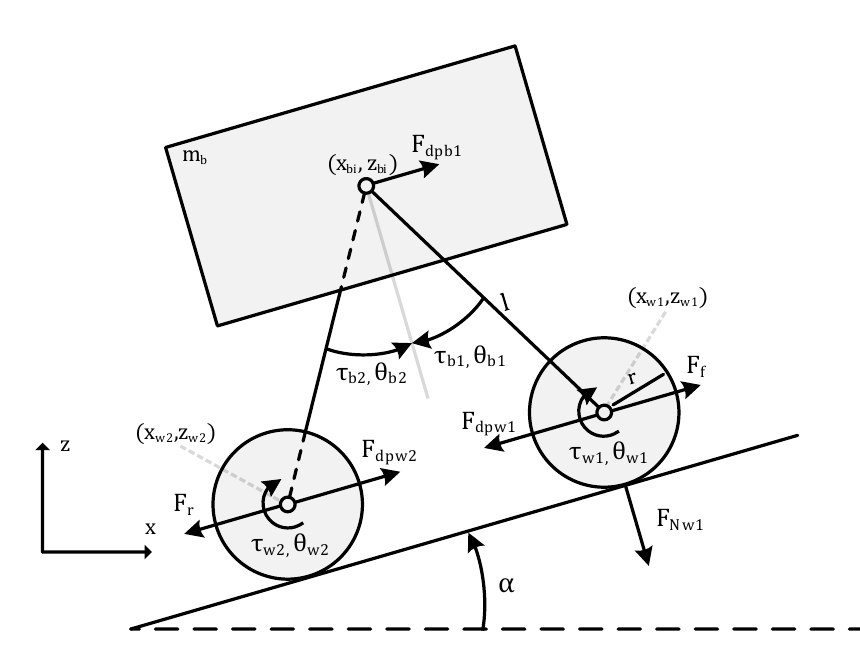
Figure 2. Diagram of the proposed wheel walking mode. It represents both steps, wheel-backward and wheel-forward that are carried out by wheels w 1 and w 2,